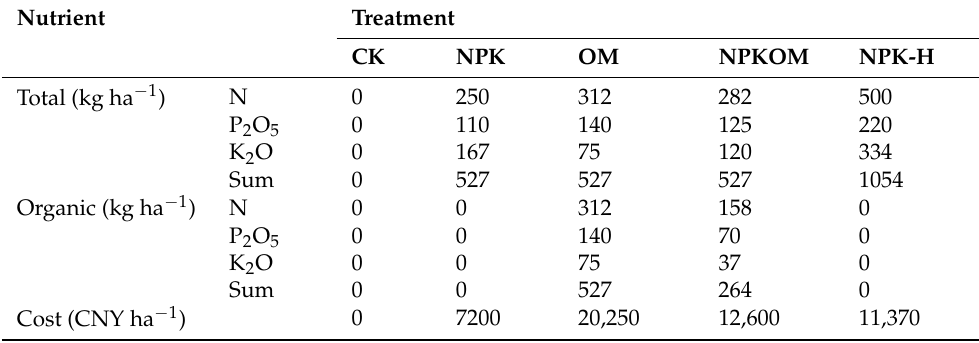
Table 1. The amount and composition of fertilizers, and the cost of fertilization including fertilizers and application of